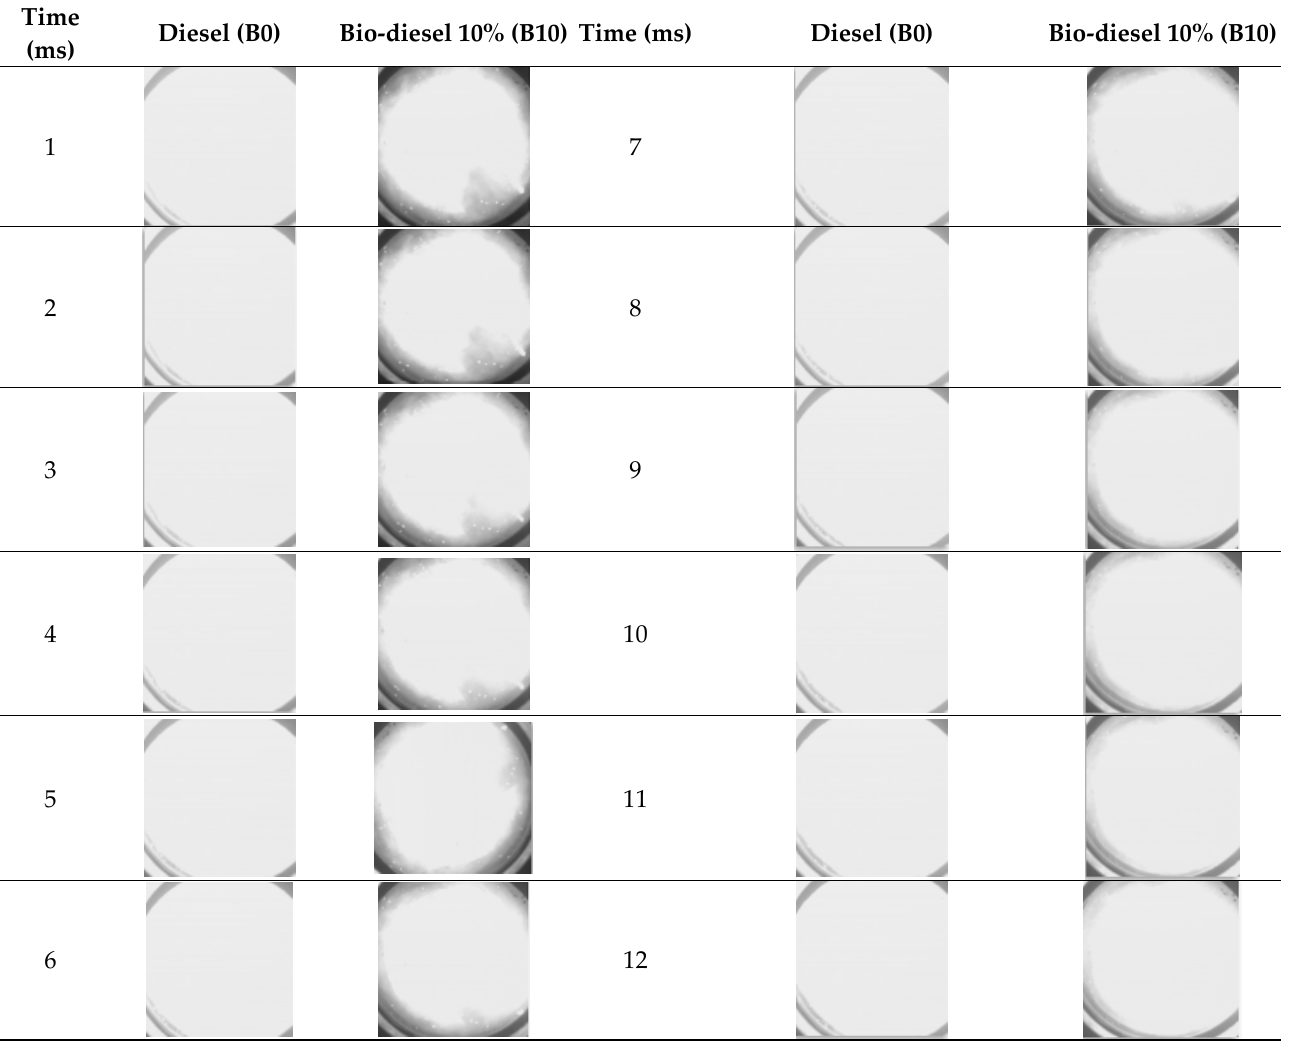
Figure 11. Progression of pressure in the CVCC combustion chamber.